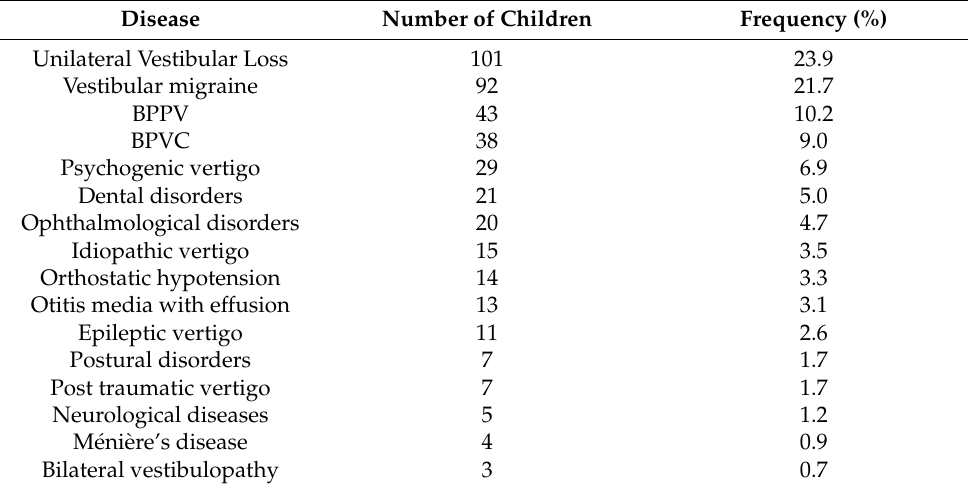
Table 1. Vertigo in pediatric age: distribution of causes (N =